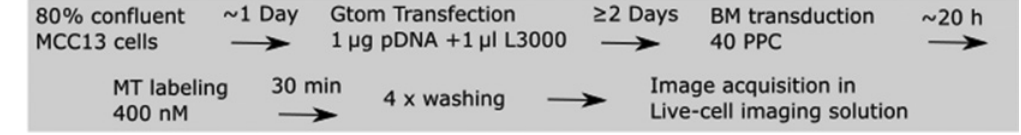
Figure 7: Flow chart summarizing the optimized protocol for three-color labeling of